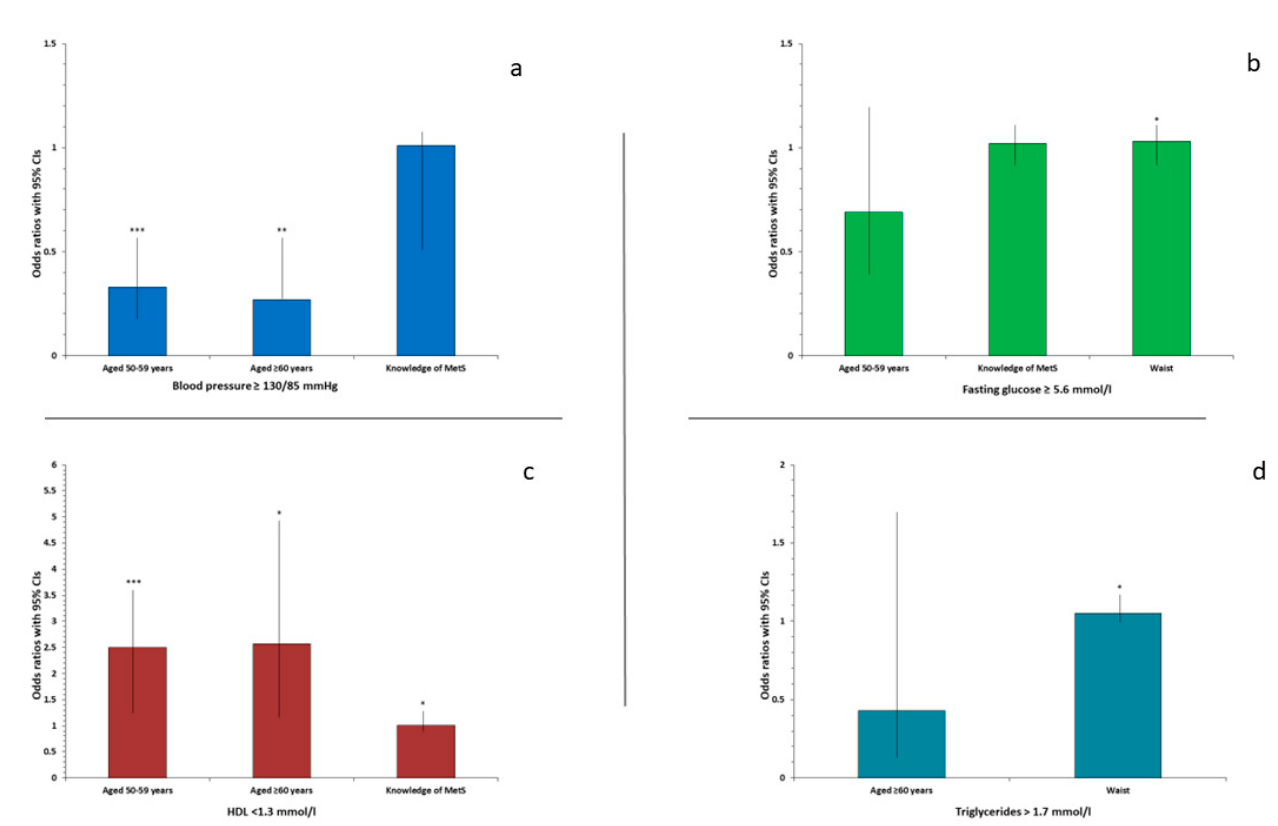
Figure 2. Risk factors associated with cardiometabolic components of MetS. ( a ). Blood pressure ≥ 130/85 mmHg, ( b ). Fasting blood glucose ≥ 5.6 mmol/L, ( c ). High density lipoprotein cholesterol (HDL) < 1.3 mmol/L, ( d ). Triglyceride levels > 1.7 mmol/l; * p < 0.05, ** p < 0.005, *** p < 0.0005.